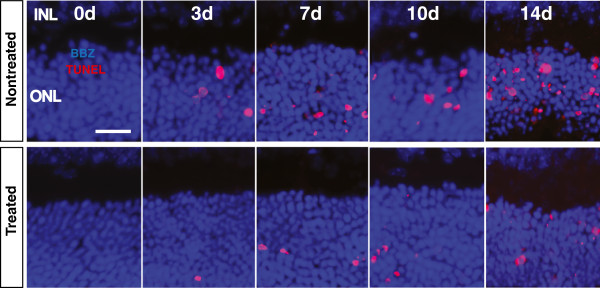
Effects of 670 nm light pretreatment on photoreceptor cell death following hyperoxia. Representative images of TUNEL-stained sections sampled from the inferior region of the NT and Tr retinas exposed to hyperoxia at different timepoints. TUNEL + labelling (red) was undetectable in the NT and Tr retinas from 0d (controls). A small population of TUNEL + photoreceptors was present in 3dNT retinas and continued to increase in number from 7, 10 and 14 days of exposure to hyperoxia. TUNEL + cells are also present in the 670 nm light-treated groups with significantly reduced number. The blue staining is Bisbenzimide, a DNA-specific stain, identifying the nuclear layers of the retina. Scale bar 25 μm.